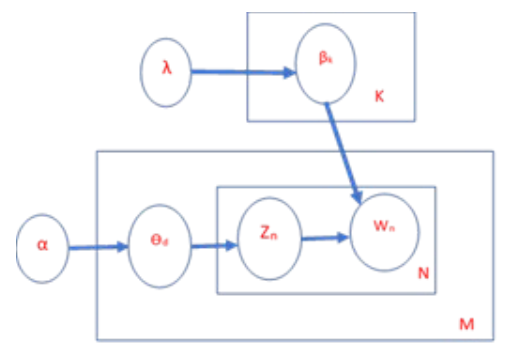
Figure 2 : Latent Dirichlet Allocation Plate Notation